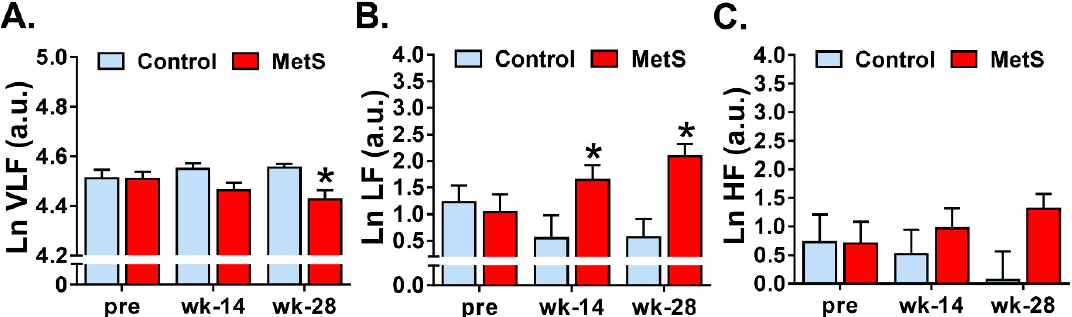
Figure 1. Frequency-domain parameters of short-term HRV analysis. Comparisons of LnVLF are shown in panel ( A ). Panel ( B ) shows the quantification in the low frequency (LF) band, whereas ln high frequency (HF) is depicted in panel ( C ) (log forms). Control n = 9, MetS n = 13. * p < 0.05 vs. control. Error bars: SEM.